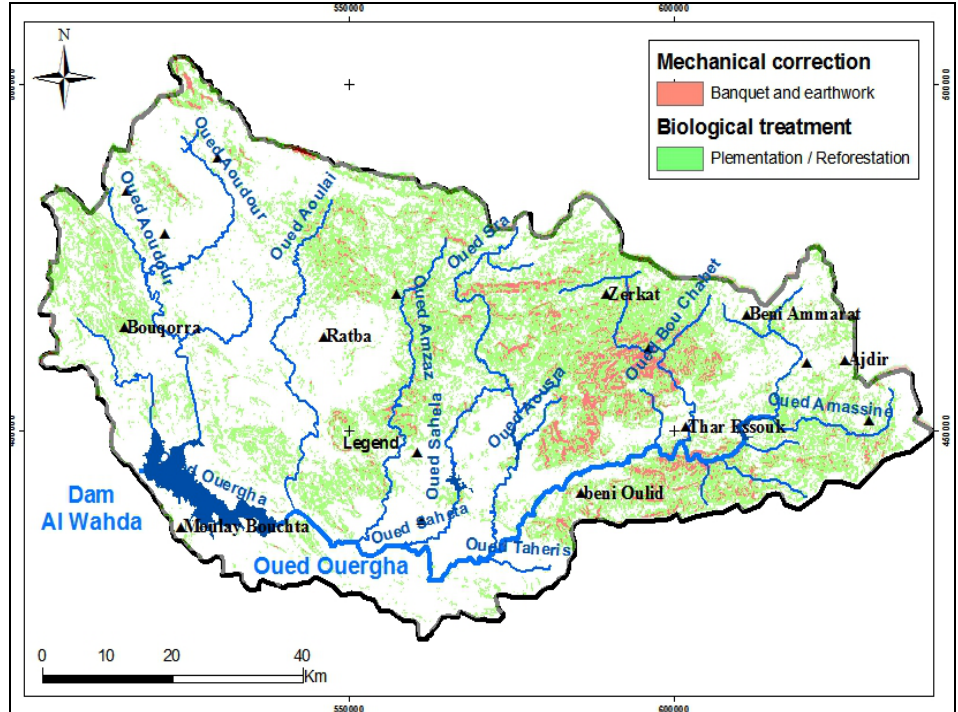
Figure 11 . Decision Map of the Priority Action